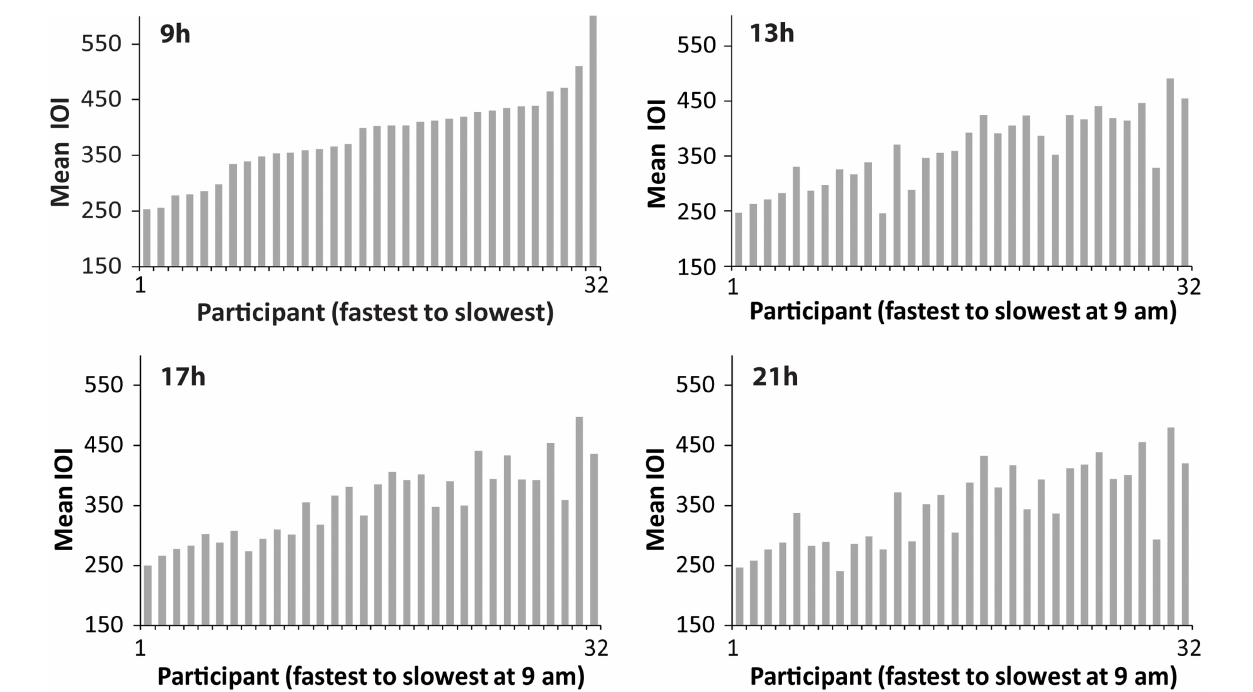
FIGURE 3 | Distributions of performers’ mean SPR values (mean IOI in ms) for the Unfamiliar melody, ordered at each testing session from fastest to slowest performer according to 09 h. Each bar = one